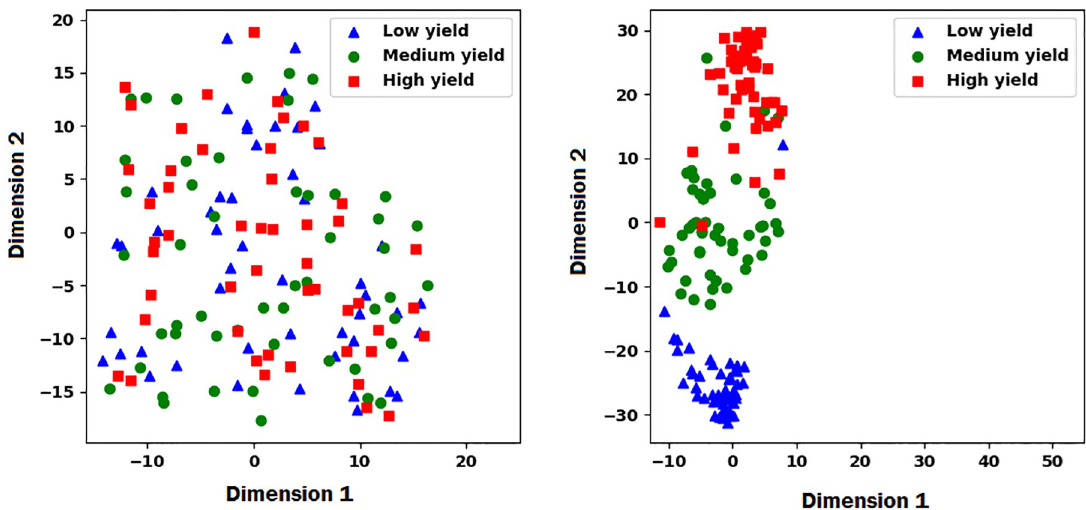
Fig 2. The left and right plots show the t-SNE embedded plot of inbred latent factors before and after training, respectively. The plots illustrate how the proposed model was able to differentiate the high, medium, and low yield inbreds based on their corresponding latent factors in the embedding